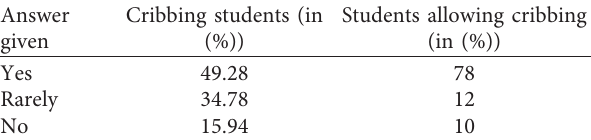
Table 2: Cribbing as a violation of academic integrity.